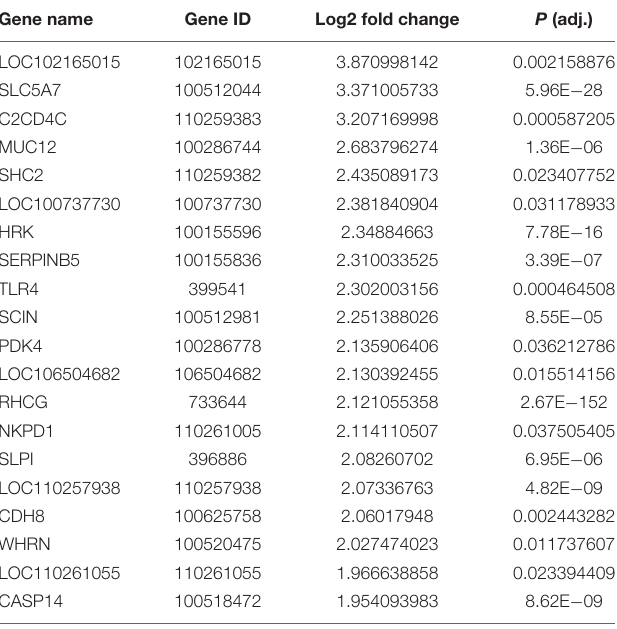
TABLE 1 | Top 20 upregulated differentially expressed genes.